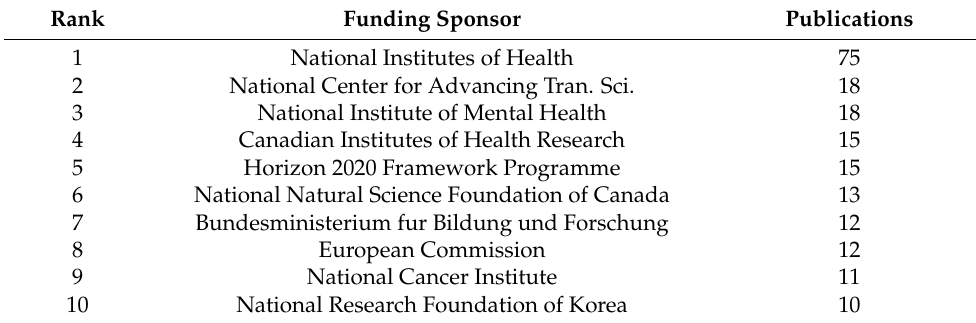
Table 3. Top 10 funding